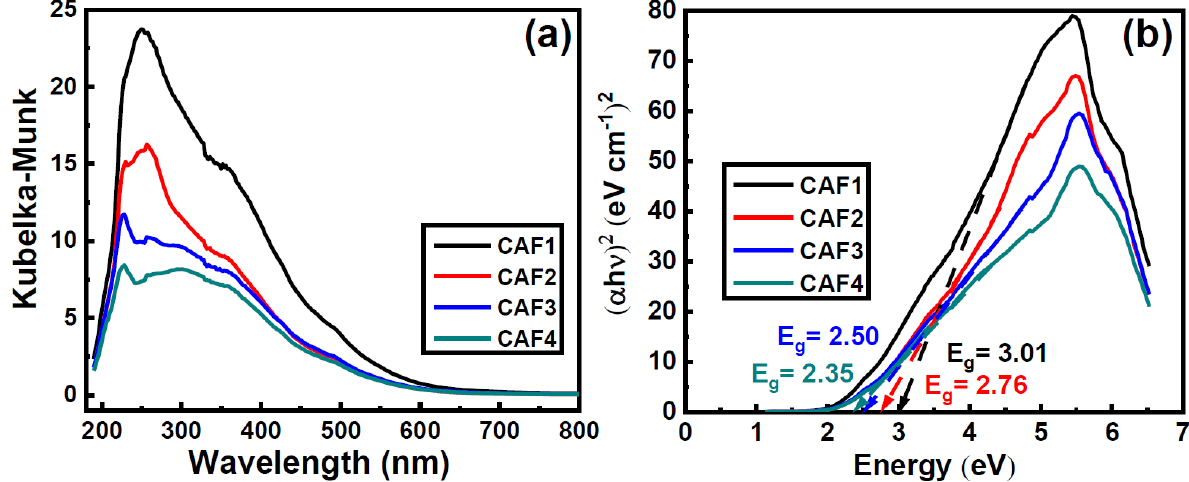
Figure 3. ( a ) Solid state UV-vis spectra and ( b ) Tauc plot of Ca – Al – Fe LDHs with various Ca/Al/Fe